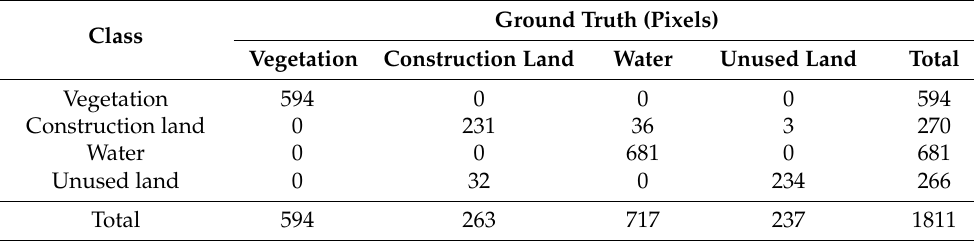
Table 3. The confusion matrix of